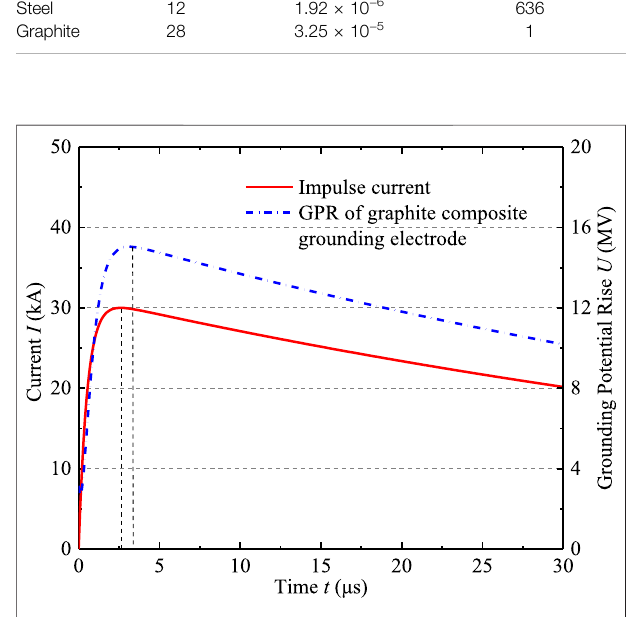
FIGURE 7 | Physical picture of the grounding electrode.